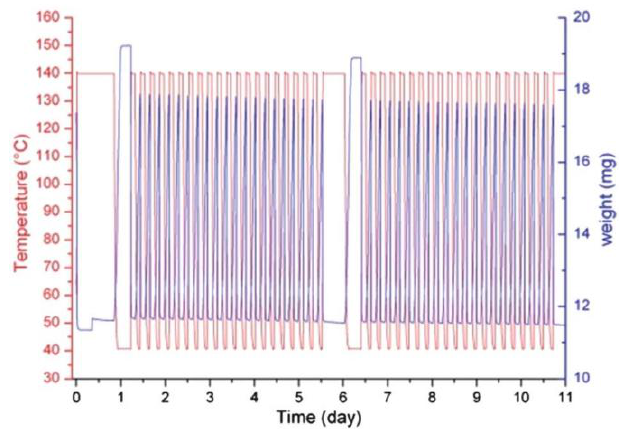
Figure 10. Temperature profile and load signal of the MIL-100(Al) cycling experiment acquired at p H2O = 5.6 kPa. Reproduced with permission from [43]. Royal Society of Chemistry,